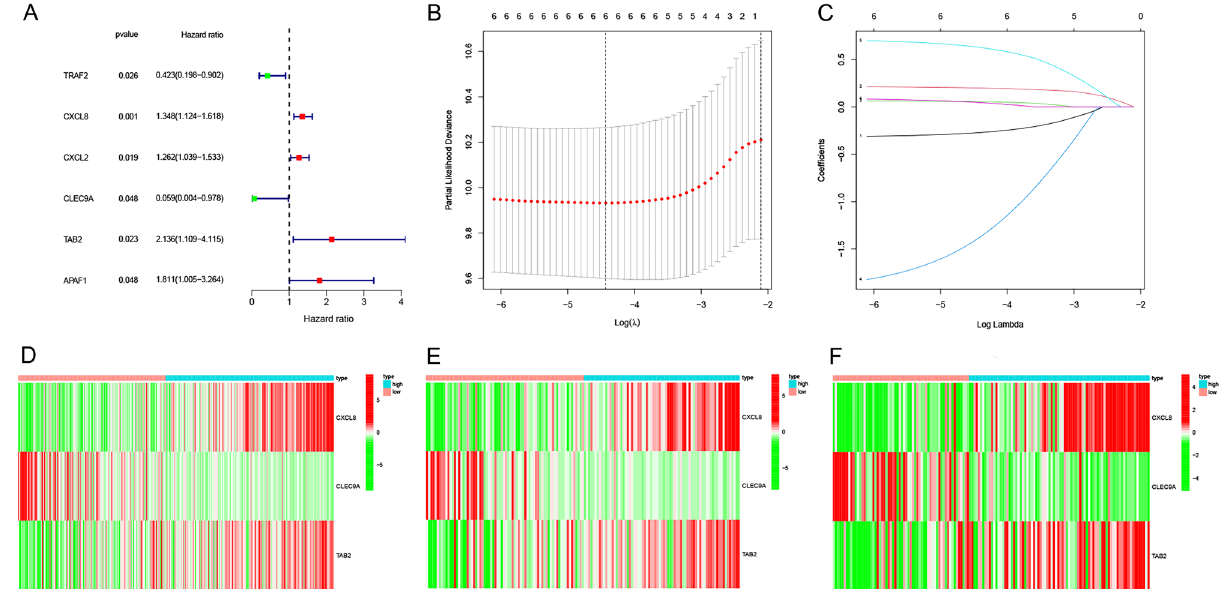
Figure 5. Screening for prognosis-related NRmRNAs in CESC patients. ( A ) Univariate COX regression analysis. ( B – C ) Lasso Cox regression analysis. ( D - F ) Heatmaps with two sets of validation datasets of the 3 NRmRNAs (green: low expression level; red: high expression